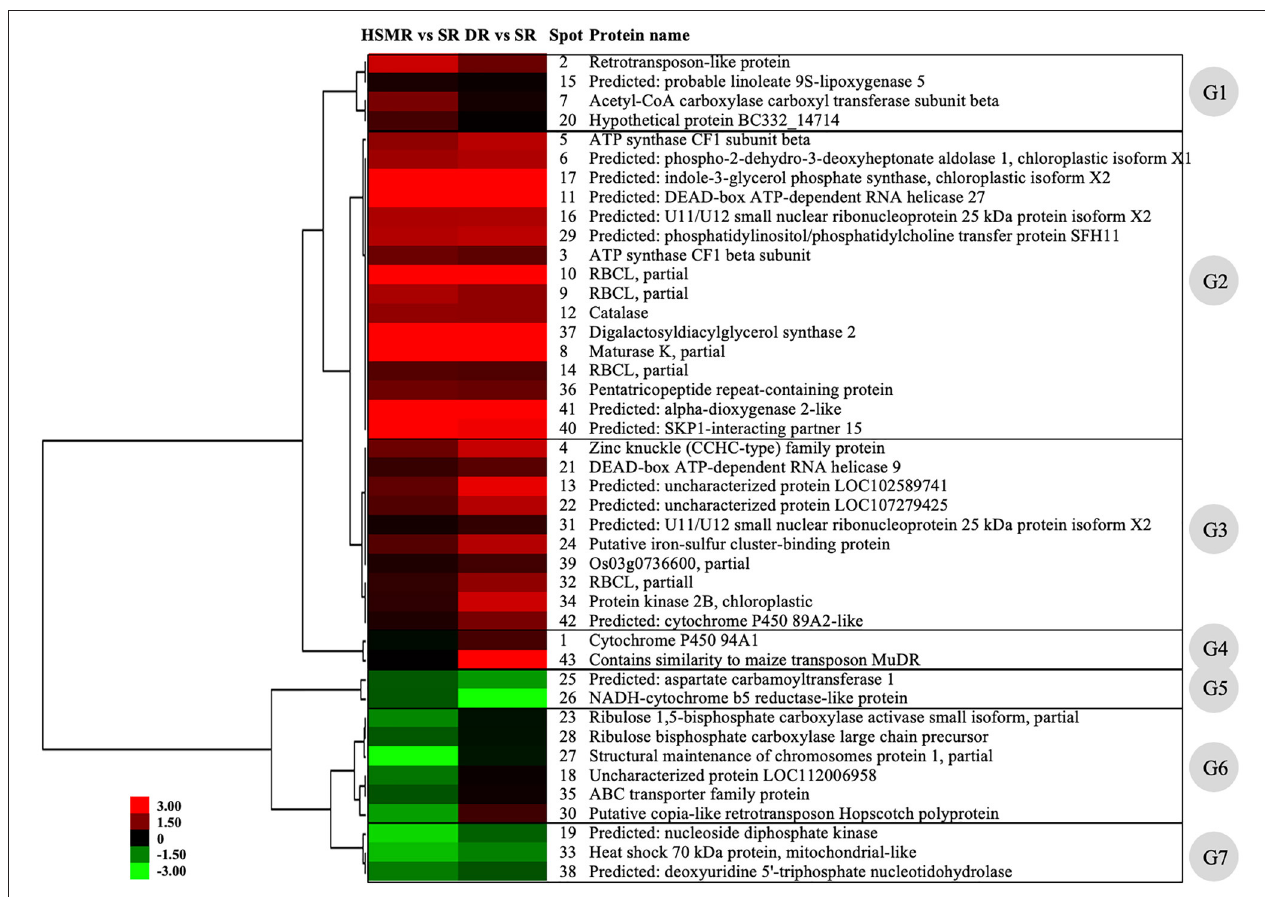
FIGURE 6 | Hierarchical clustering analysis of the differentially accumulated proteins (DAPs) from three different ecotypes reed. The upregulated or downregulated proteins are presented in red or green. The intensity of colors stands for the abundance of protein as shown in the bar at the left of the figure. G1–G7 represent the seven clusters with different expression patterns among these